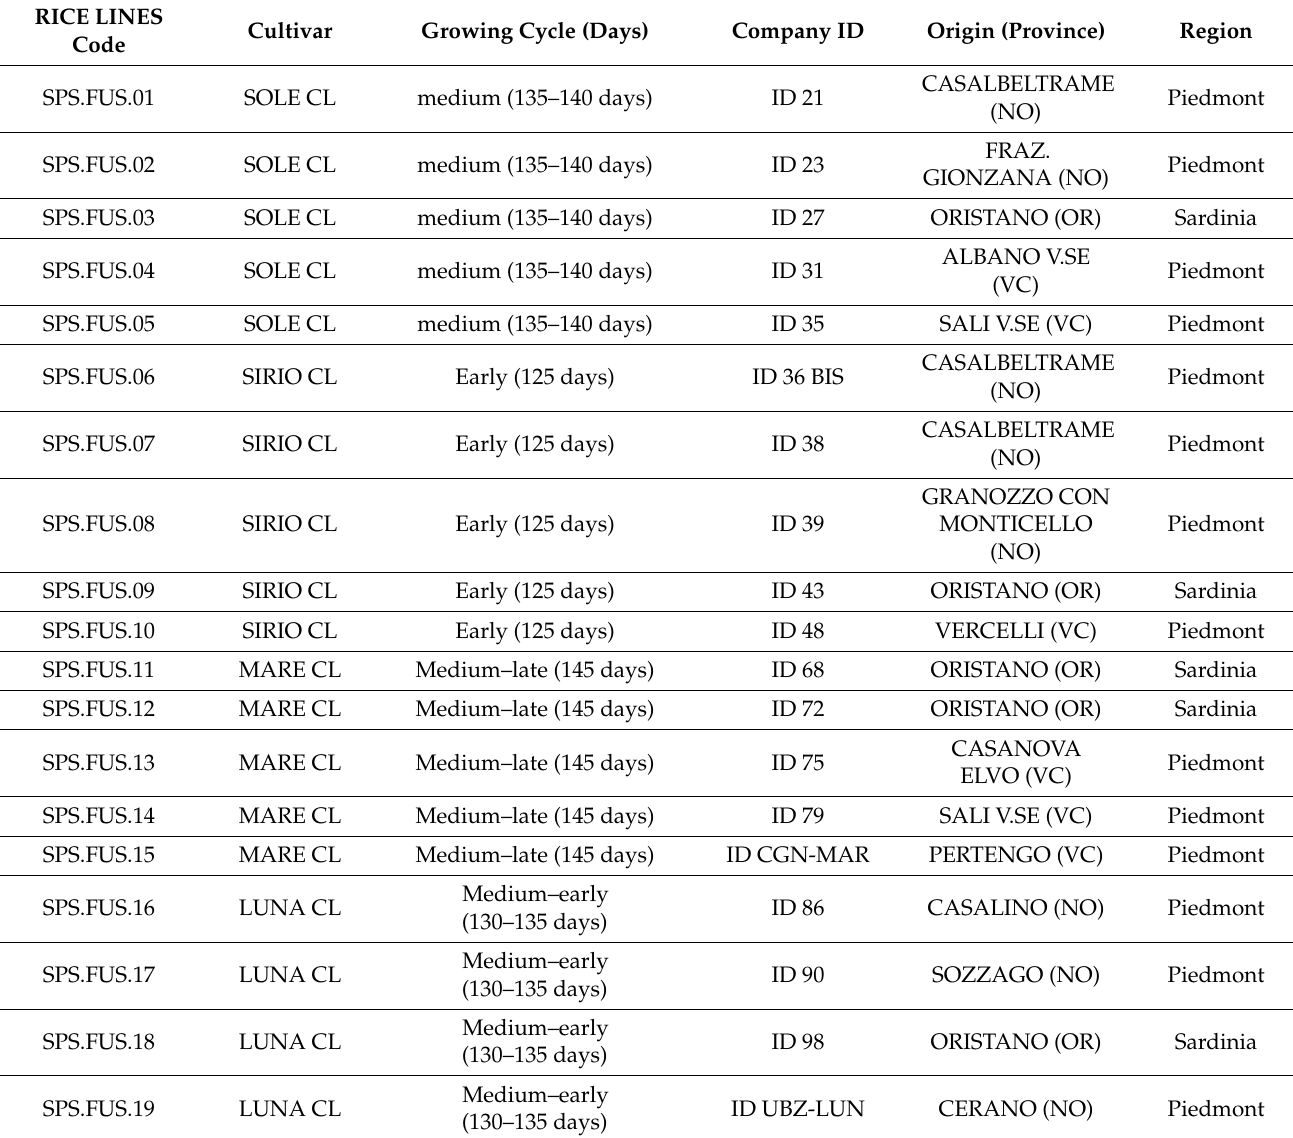
Table 1. Rice seed lines ( Oryza sativa subsp. japonica ) used in the